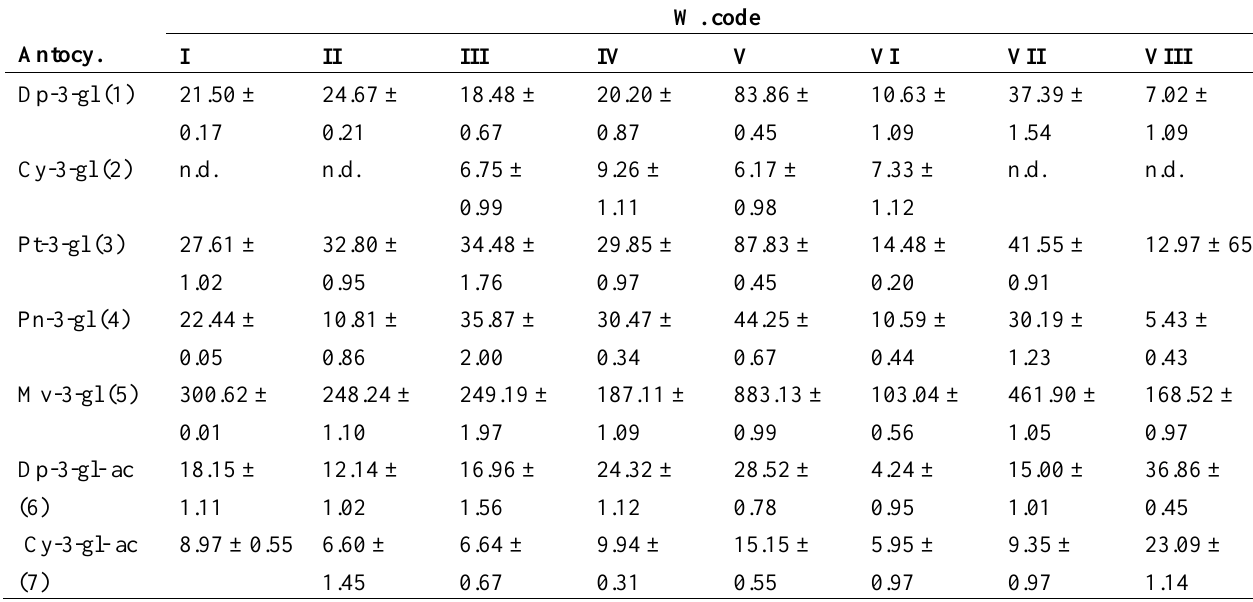
Table 3. Content of individual anthocyanins and total anthocyanin content of the wines samples (mg/L ± SD, n =